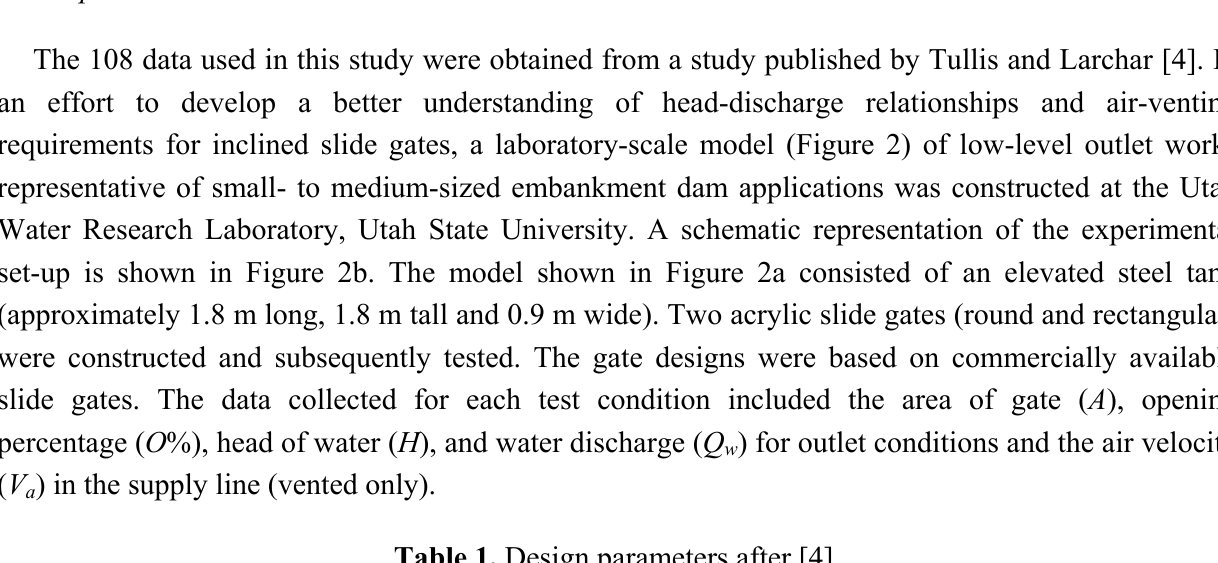
Table 1. Design parameters after